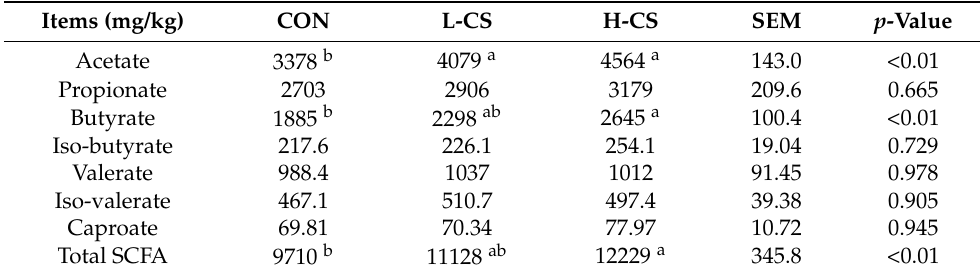
Table 4. Effect of chitosan on fecal SCFAs in cats.